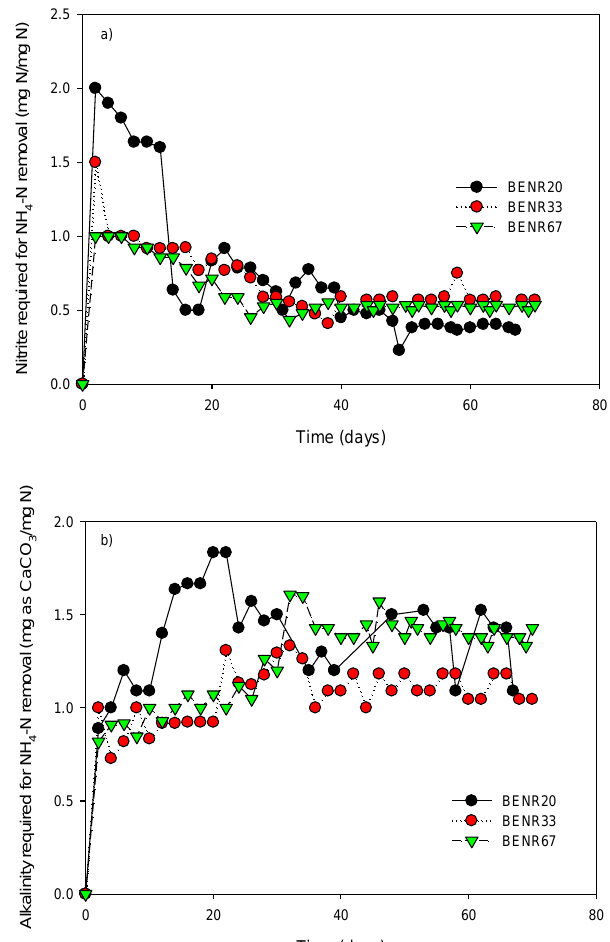
Figure 3. Consumptions of nitrite and alkalinity for ammonium removal in bioelectrochemical nitrogen removal reactors: ( a ) nitrite and ( b ) alkalinity.